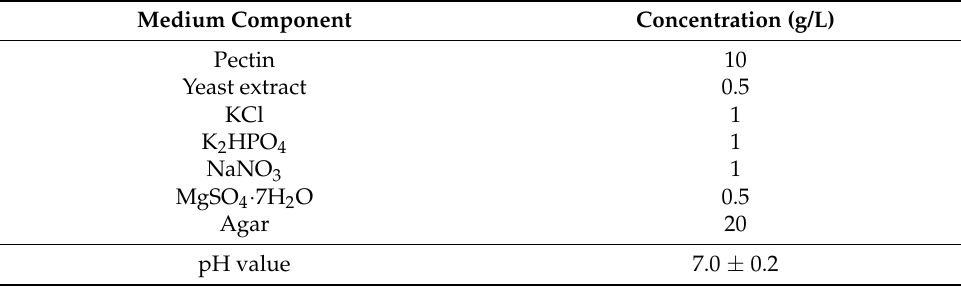
Table 3. Medium composition for the pectinase activity